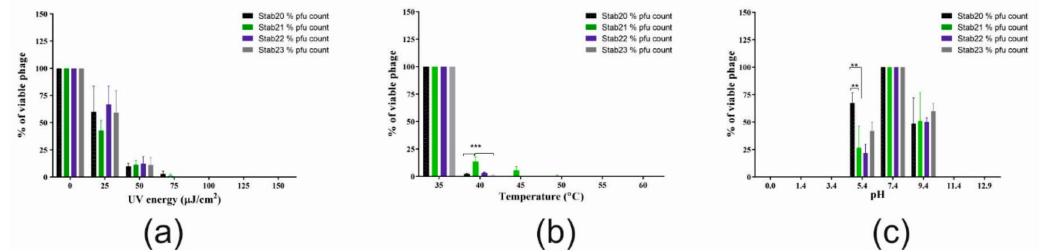
Figure 2. Stability of phages Stab20, Stab21, Stab22, and Stab23 under di ff erent environmental conditions. UV irradiation ( a ), Temperature ( b ) and pH ( c ).